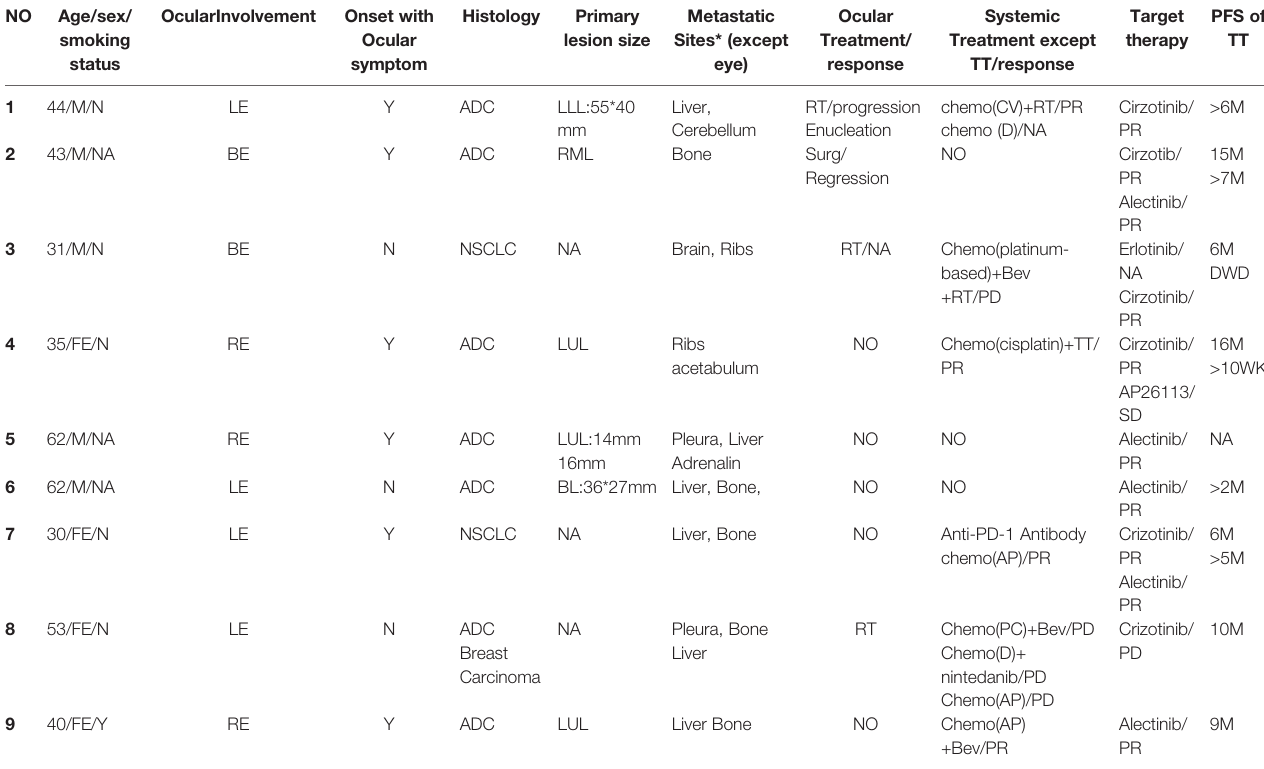
TABLE 1 | Clinical data of 9 Reviewed lung cancer cases with eye